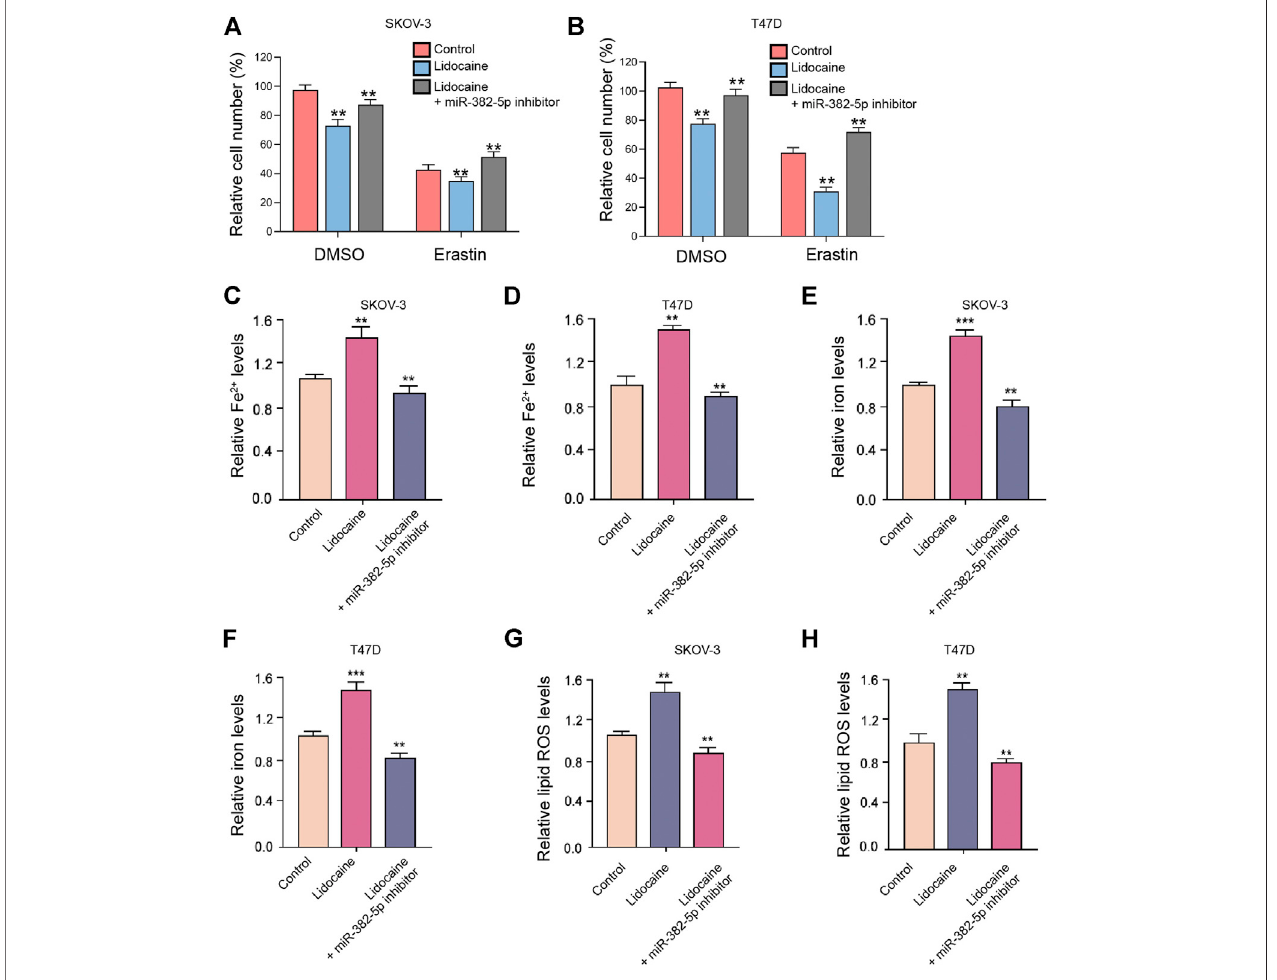
FIGURE5| TheinhibitionofmiR-382-5p blockslidocaine-inducedferroptosisofovarianandbreastcancercells. (A,B) Theerastin(5 mmol/L)-stimulatedSKOV-3 andT47Dcellswereco-treatedwithmiR-382-5pinhibitorandlidocaine(3 mM).ThecellviabilitywasdetectedbyMTTassaysafter48 hofthetreatment. (C – H) SKOV-3 andT47Dcellswereco-treatedwithmiR-382-5pinhibitorandlidocaine.TheFe 2+ (C,D) ,iron (E,F) ,andlipidROSlevels (G,H) weredetected.mean ± SD,** p < 0.01.The experiments were performed independently three times.